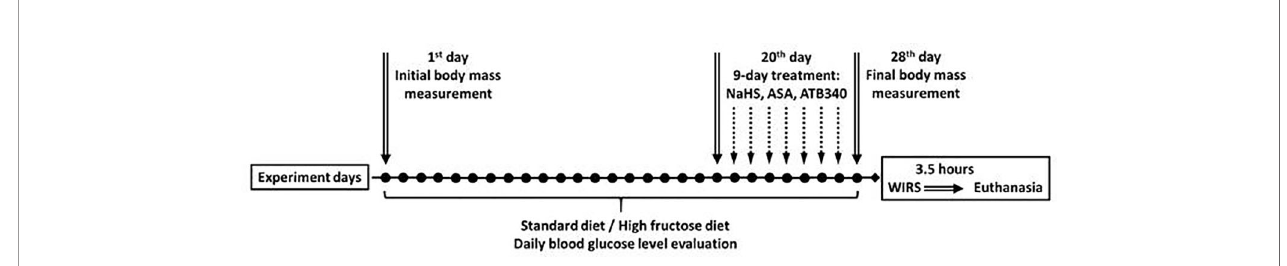
FIGURE 2 | Design of the experiment.